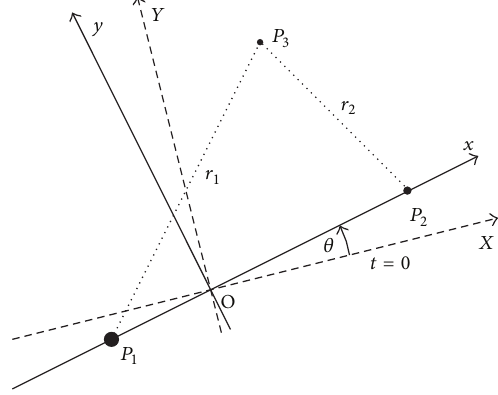
Figure 1: The rotating coordinate system (O xy ) with angular velocity 𝜔 relative to the inertial frame (O XY ). The two primaries and the massless body are denoted by 𝑃 1 , 2 and 𝑃 3 ,